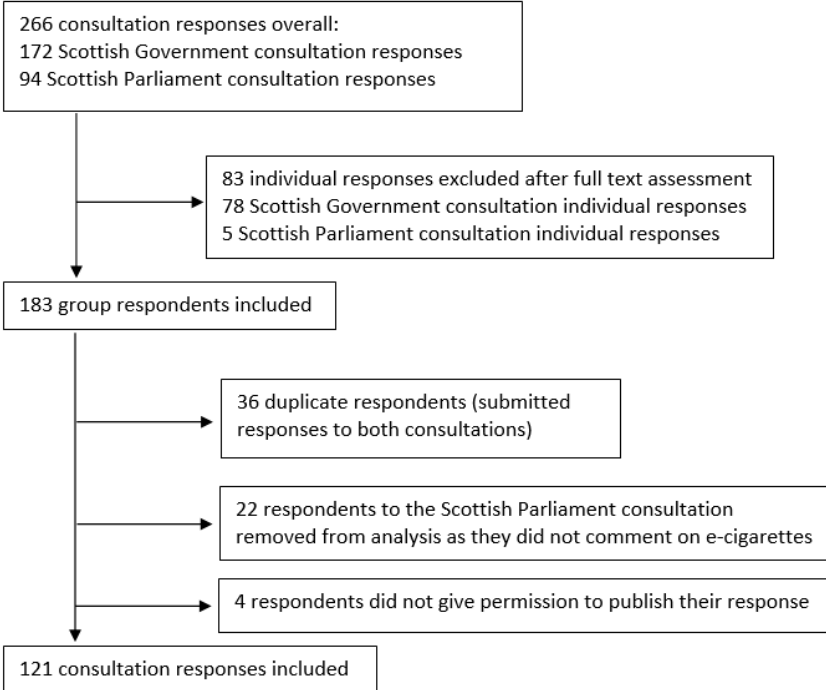
Figure 1. Flowchart of selection of consultation documents.